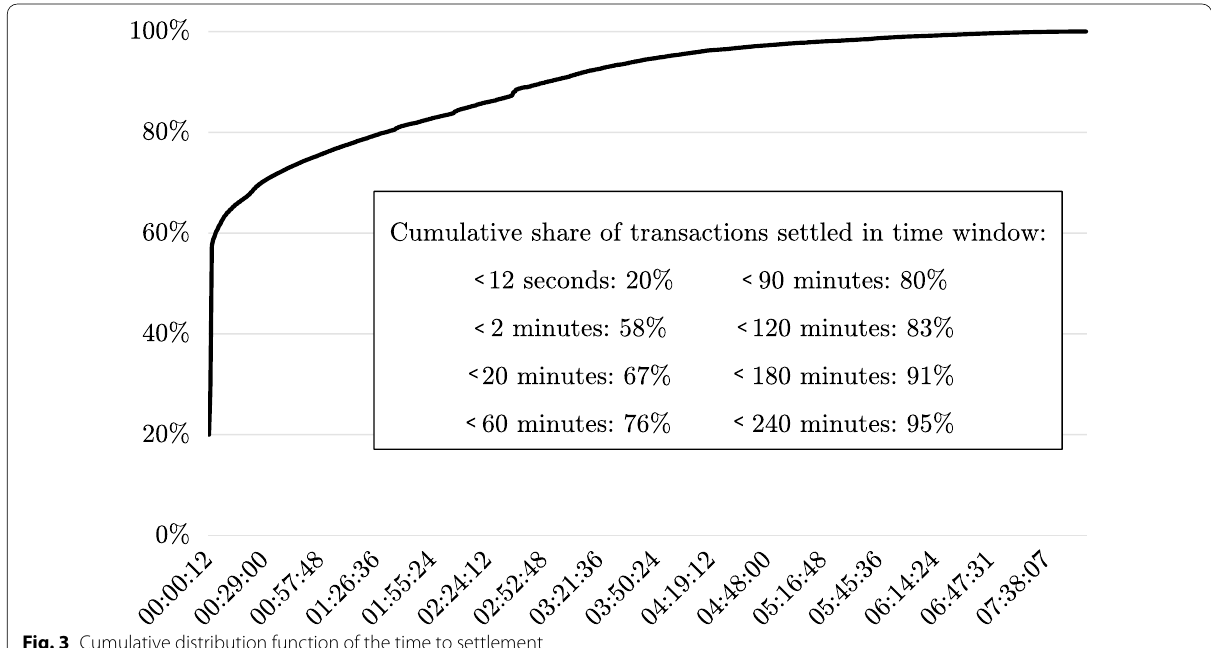
Fig. 3 Cumulative distribution function of the time to